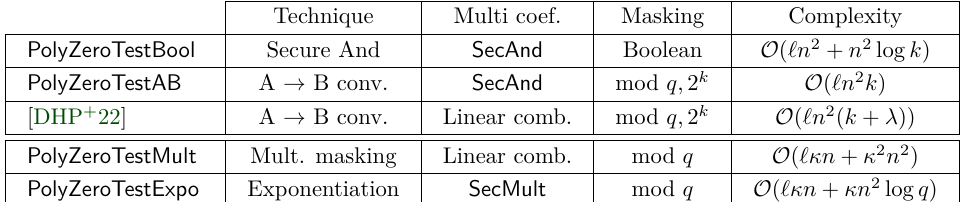
Table 1: Complexities of polynomial comparison, with ℓ coefficients and n shares, and a Technique Multi coef. Masking